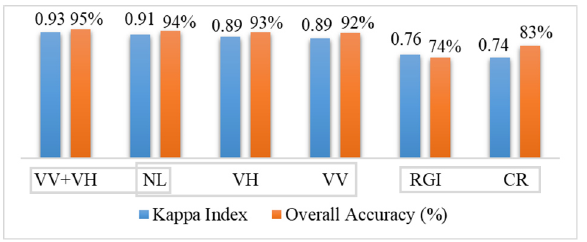
Figure 5. Classification accuracies obtained using different channels. Rectangles indicates three different groups formed after